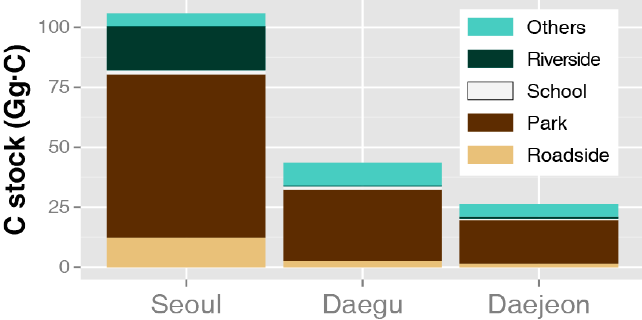
Figure 2. Soil C stock at 30-cm depths of urban green spaces in Seoul, Daegu, and Daejeon (South Korea).